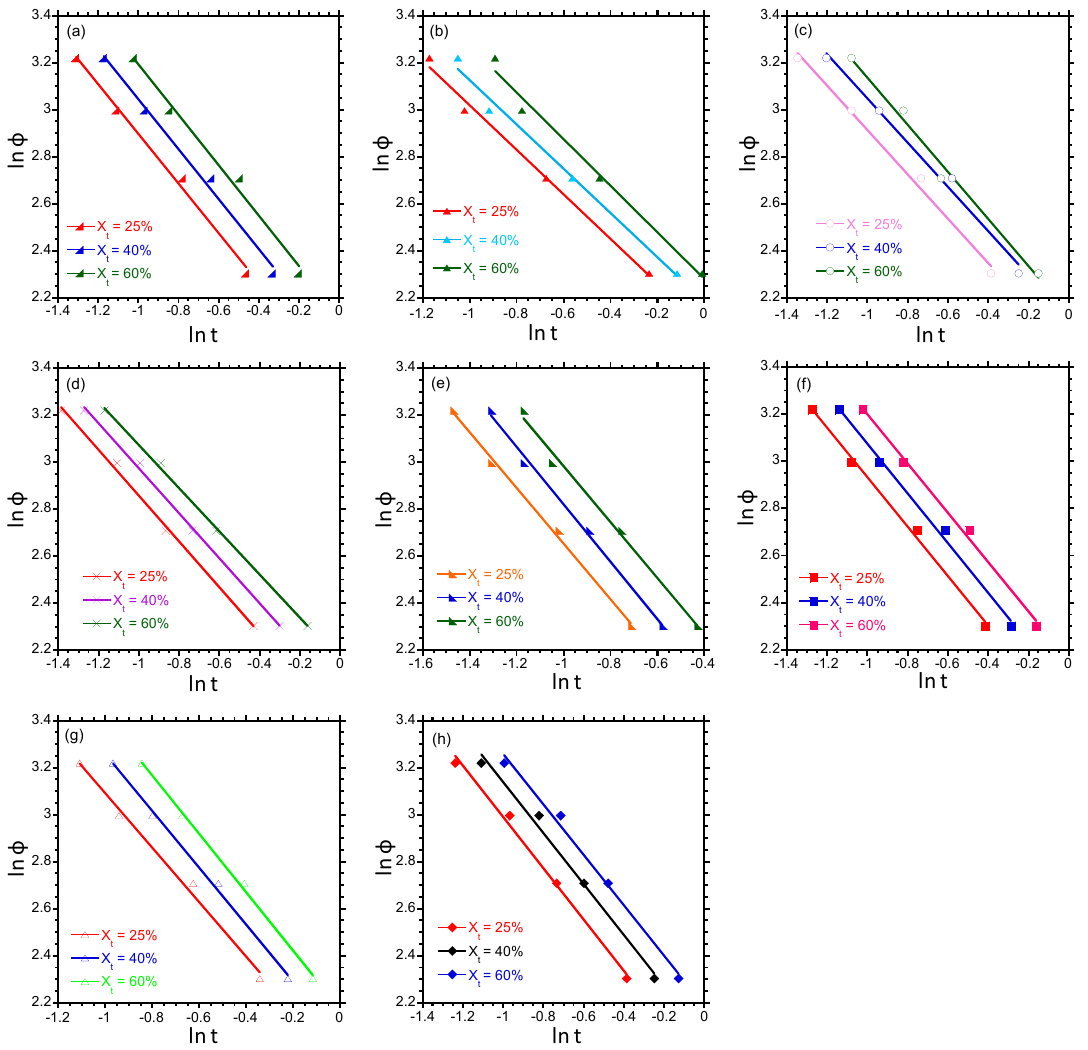
Figure 3. Plots of ln φ versus ln t for PP/LDPE/PP- g -MA/PE- g -MA/clay: ( a ) 100/0/0/0/0, ( b ) 96/0/0/0/4, ( c ) 91/0/5/0/4, ( d ) 80/20/0/0/0, ( e ) 80/20/0/0/4, ( f ) 80/20/5/0/4, ( g ) 80/20/0/5/4, and ( h ) 80/20/5/5/4. Table 3. Kinetic parameters based on the Liu model.